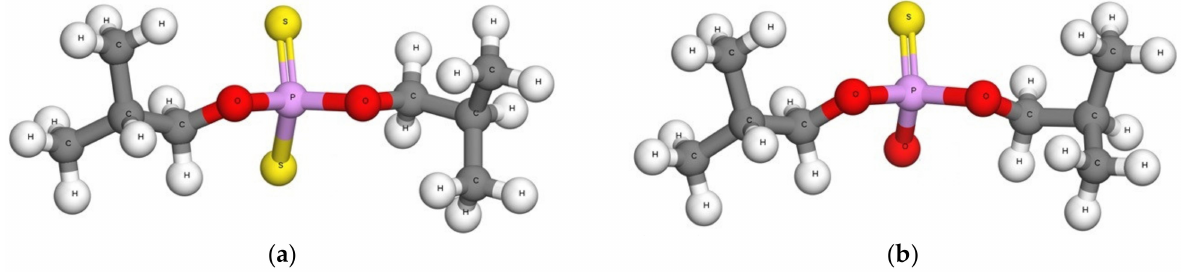
Figure 1. Chemical structures of DTP ( a ) and MTP ( b ). White: hydrogen; grey: carbon; red: oxygen; pink: phosphorus; yellow: